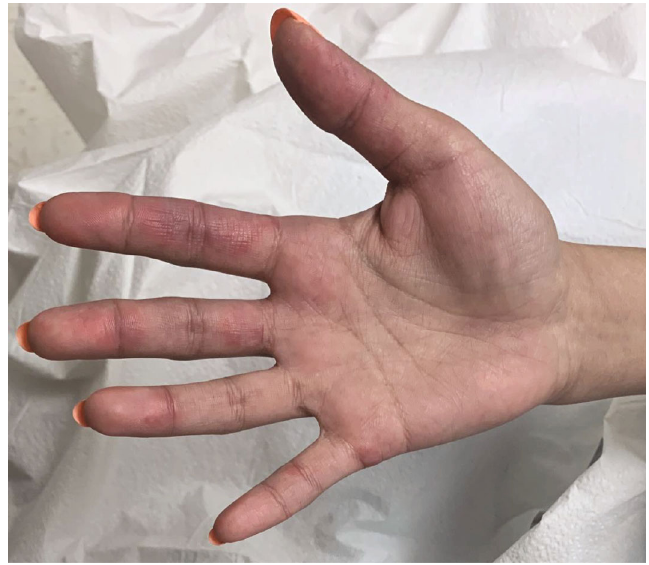
Figure 9: Painful, subtly dusky papules and plaques on the fi ngers of a patient with chilblains